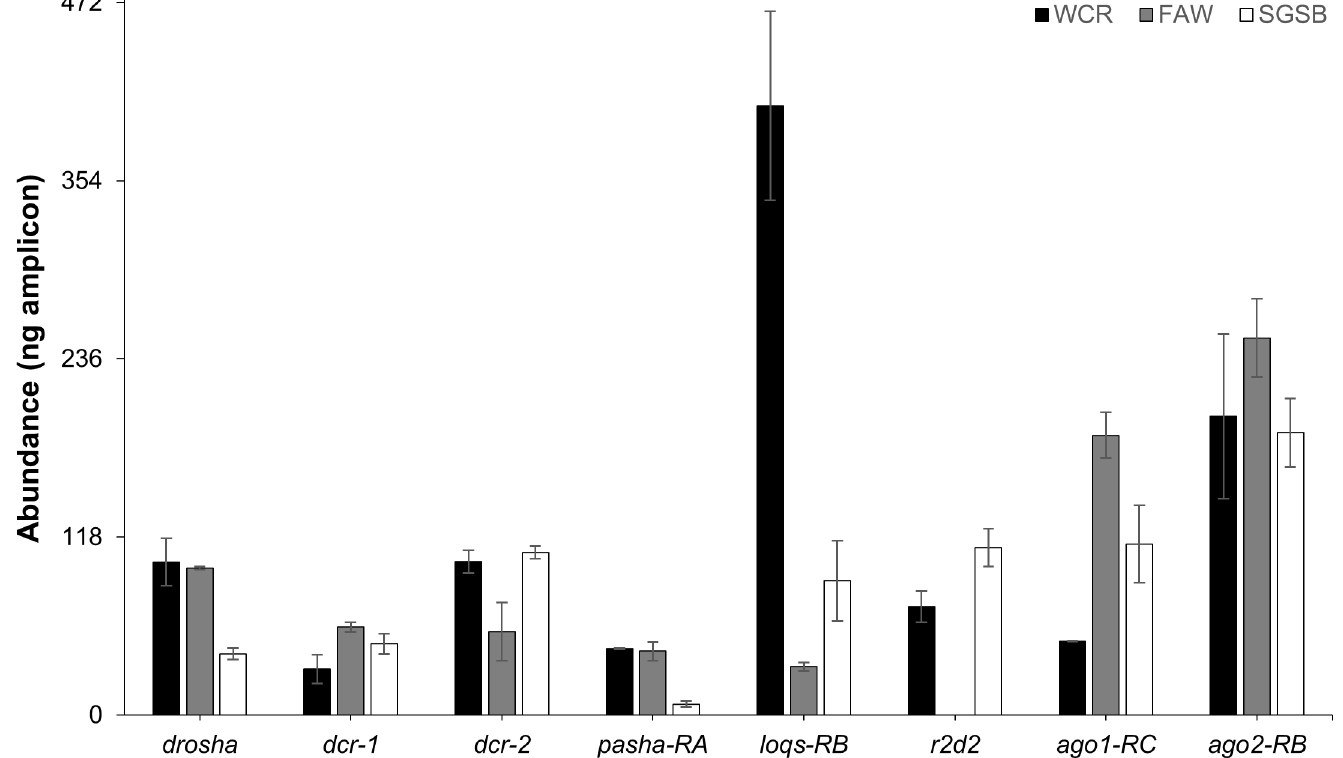
Fig 7. Comparison of core RNAi machinery expression level across WCR, FAW and SGSB. Expression was determined in first instar WCR and FAW and second instar SGSB using optimized semi-quantitative PCR at the end of 31 cycles of amplification, with the exception of SGSB pasha and FAW loqs . An additional two cycles of amplification were needed to quantify expression of these targets, and values were back-calculated using an assumed 100% PCR reaction efficiency to arrive at the reported values. Median amplicon abundance (n = 3, ± MAD) is shown for the isoform specified, excluding SGSB r2d2 and WCR ago2 where primers detected all isoforms. Quantitative expression of the top FAW r2d2 candidate was not